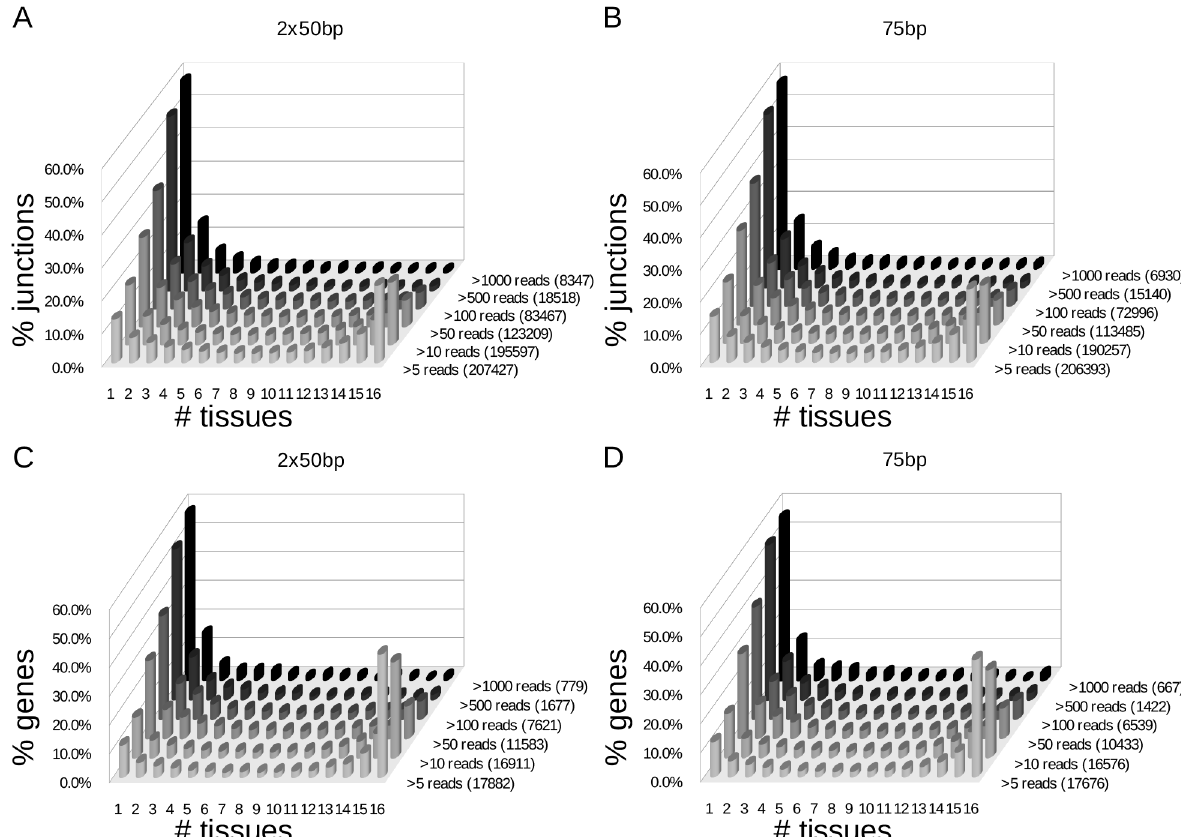
Fig 3. Gene and splice junction distribution. The percentage of genes or splice junctions found in the indicated number of tissues over a set threshold of reads from paired-end (2x50bp) and single end (75bp) reads. In parenthesis is the total number of genes or splice junctions found over a set threshold of